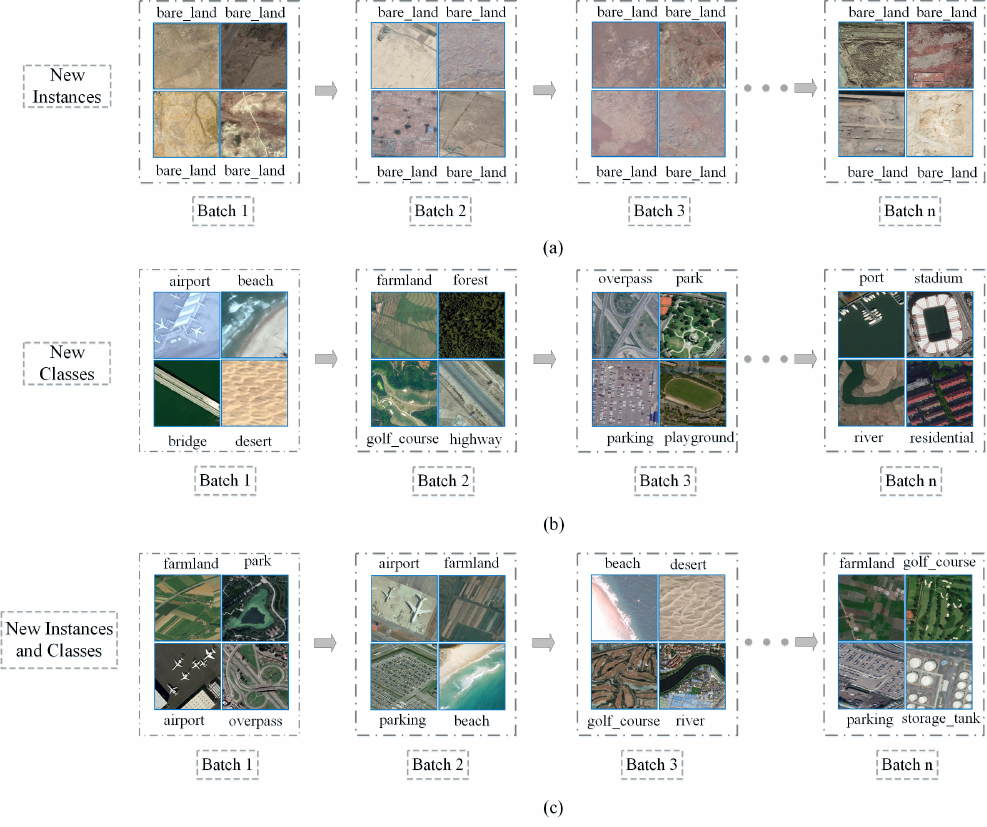
Figure 1. ( a ) New Instances scenario (NI): The bare_land in Batch 1, Batch 2, Batch 3, · · · Batch n are different in background, texture, resolution, area, etc. ( b ) New Classes scenario (NC): Different scene categories appear in subsequent training batches. ( c ) New Instances and Classes scenario (NIC): Subsequent training batches contain new scene categories and new instances of the same